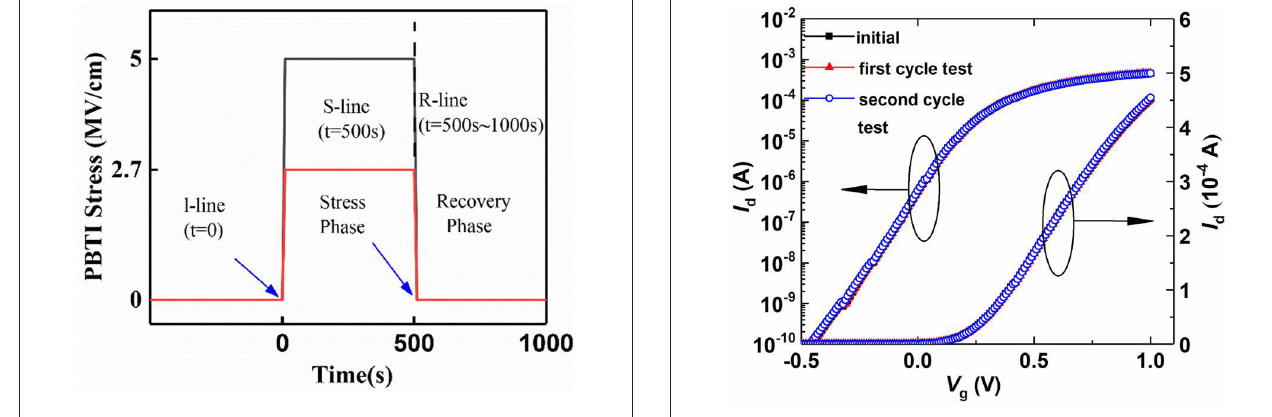
FIGURE 4 | Comparison of DC I d - V g measurement curves of the buried In 0.25 Ga 0.75 As channel n-MOSFETs under different test